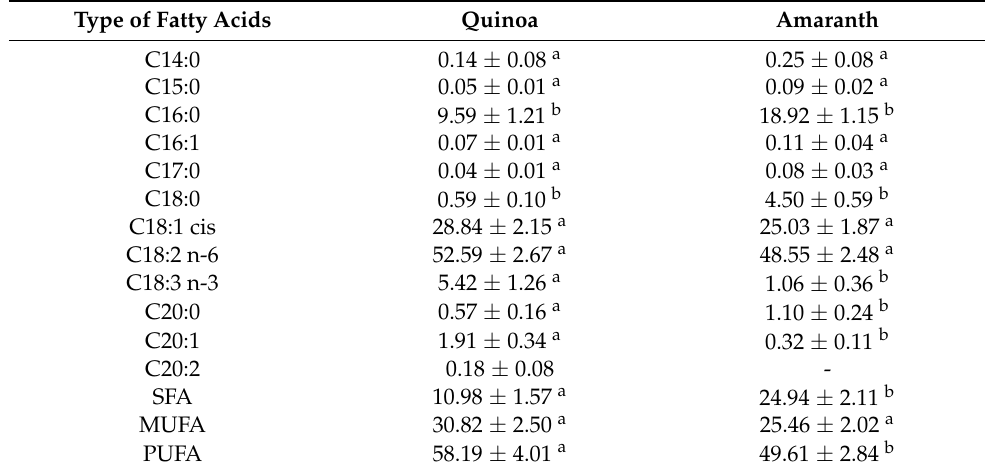
Table 2. Fatty acids composition (%) of oil extracted from quinoa and amaranth